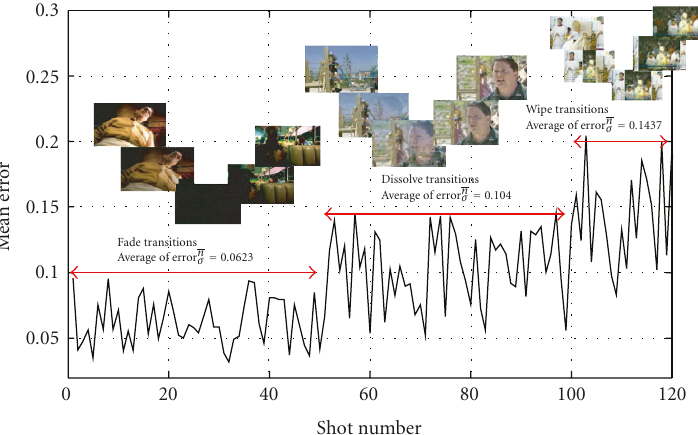
Figure 4: The diagram of Error n for all di ff erent types of gradual shot transitions that have been extracted from TRECVID 2006 and the σ dataset is shown in Table